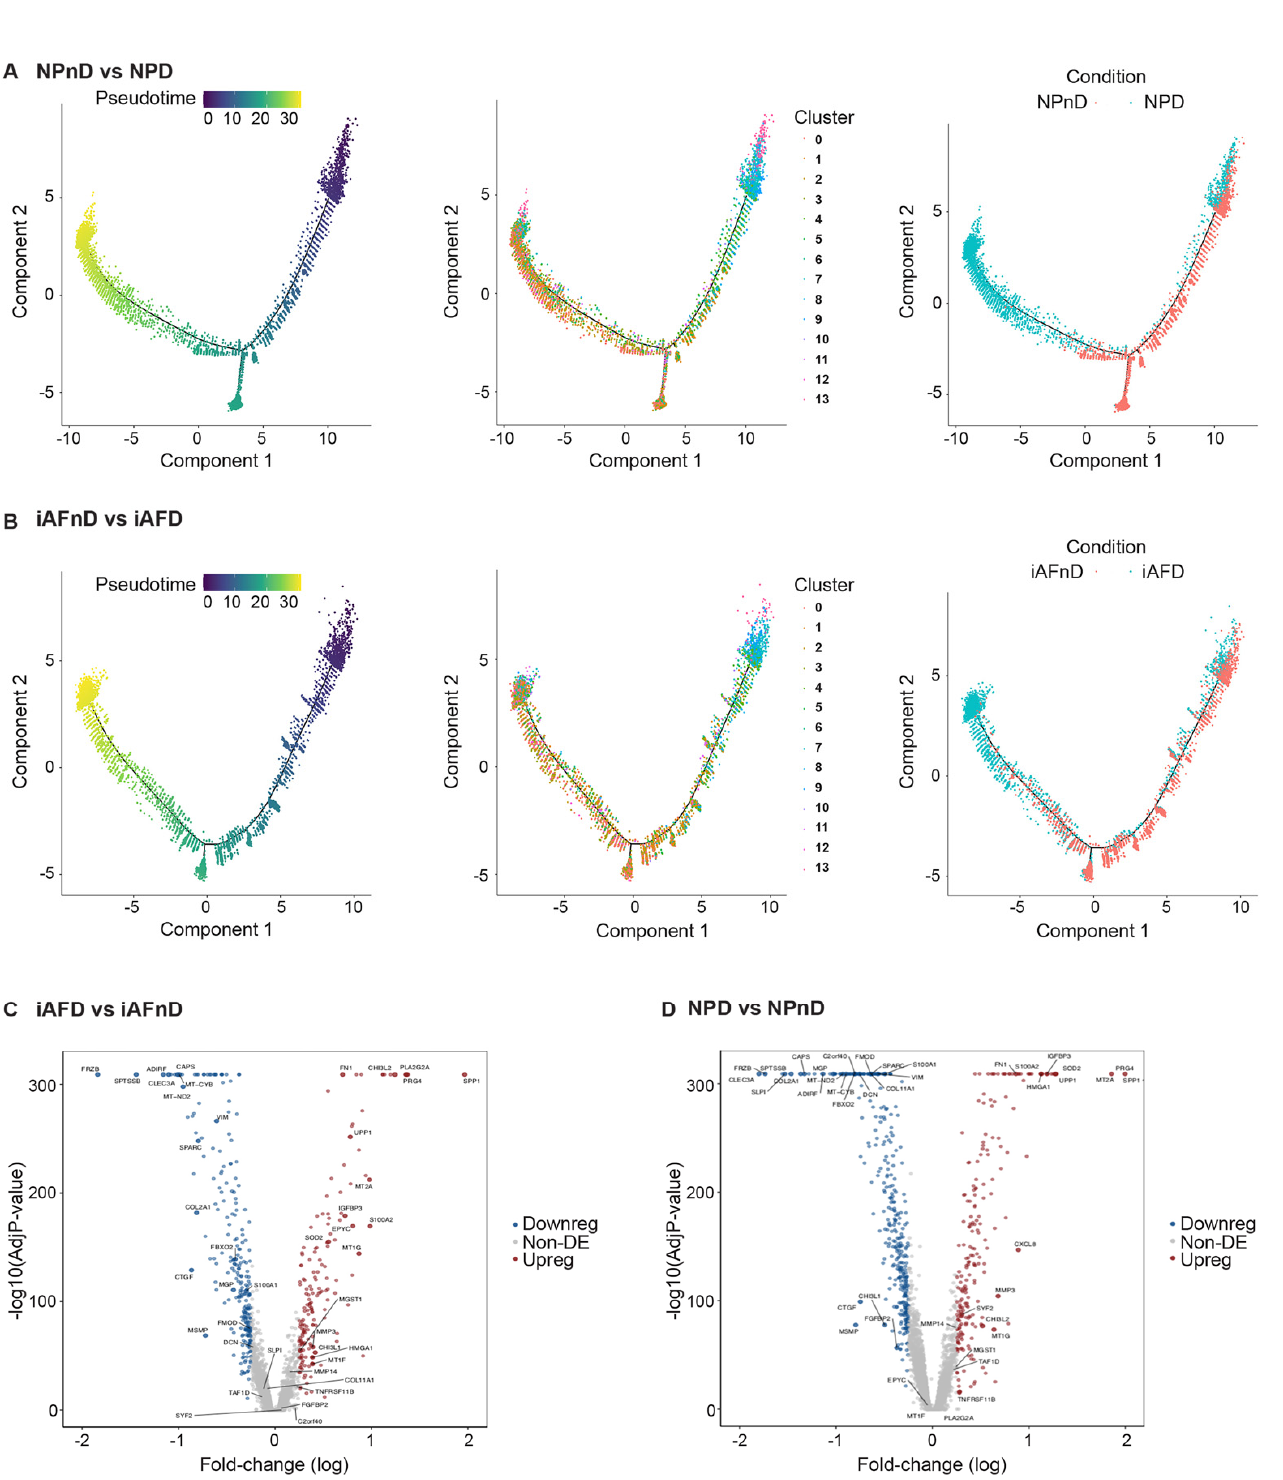
Figure 4. DEGs in iAF and NP cells from nD and D discs. Monocle method reconstruction of pseudotime trajectory axis and pseudospace trajectory for ( A ) NPnD vs. NPD and ( B ) iAFnD vs. iAFD defined cell clusters along the progression of IVD degeneration. Volcano plot depicting differentially expressed genes in D compared with nD ( C ) iAF and ( D ) NP cells. Red, grey and blue circles represent upregulated, non-differentially expressed and downregulated genes, respectively.